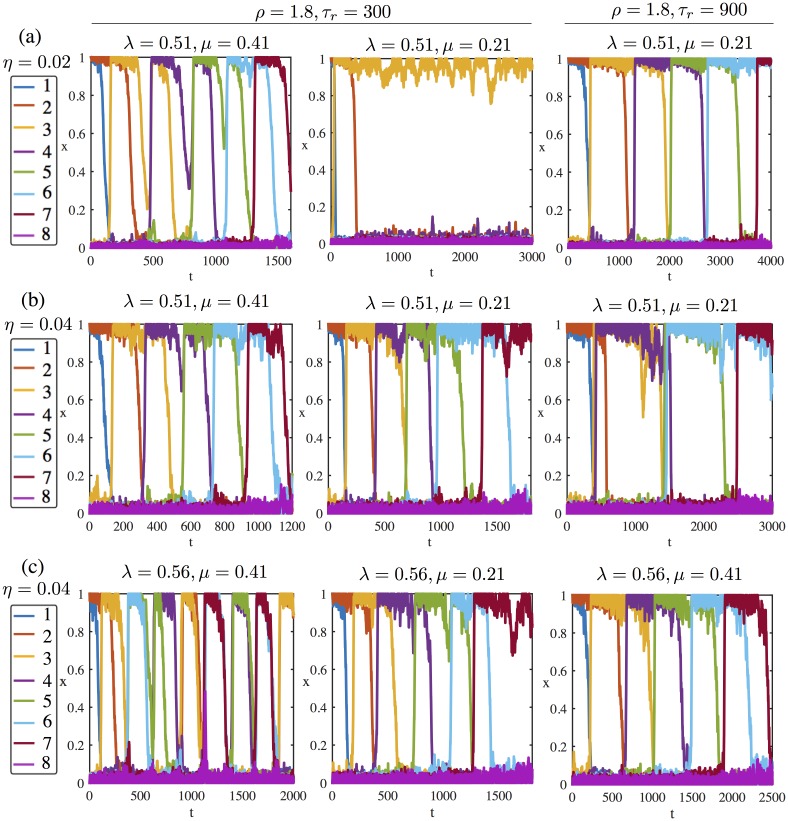
Response of the system initialised from pattern A (units 1-2) to different levels of noise η and system parameters λ, μ, τr.Synaptic variables are faster along the first two columns (τr = 300) than the last column (τr = 900). In all simulations I = 0. Row (a) η = 0.02, λ = 0.51. The system with fast synapses can follow the longest sequence from A (units 1-2) to F (units 6-7) for μ = 0.41 (the first panel) but not for μ = 0.21 (the second panel), while the slow synapses can trigger the longest sequence (the third panel). Row (b) η = 0.04, λ = 0.51. Increasing the noise amplitude enables the activation of the whole sequence with fast synapses (the first two panels), whereas the slow synapses give either very short patterns or 3 co-active units, the third panel, respectively. Row (c) η = 0.04, λ = 0.56. Increasing the global inhibition λ regulates the transition for slow synapses (the third panel), whereas the system with fast synapses and μ = 0.41 (the first panel) randomly activates learned patterns and yields short regular and irregular sequences. On the other hand, the system with μ = 0.21 and fast synapses (the second panel) can preserve a regular sequence.